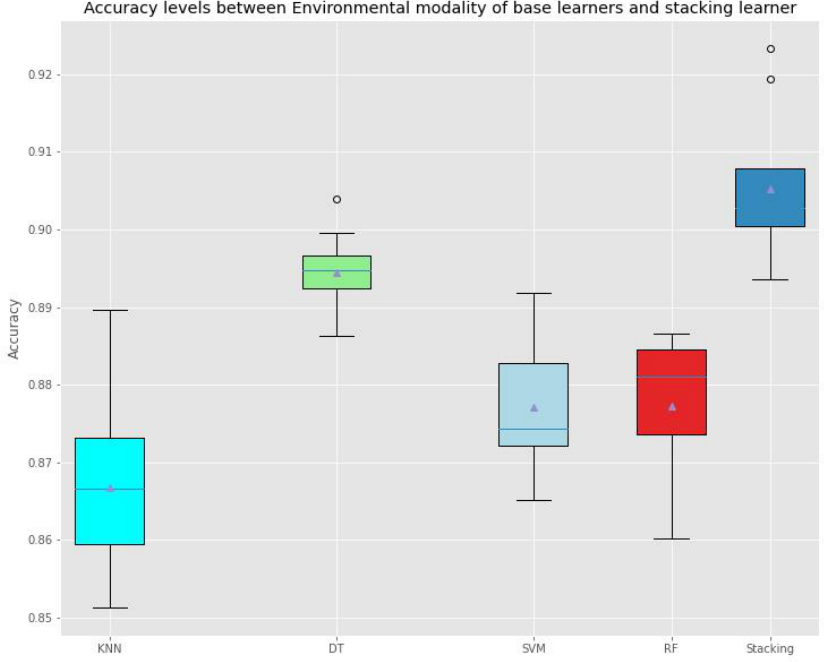
Figure 16. Accuracy Levels Comparison between Base classifiers of Environmental Modality and the Stacking